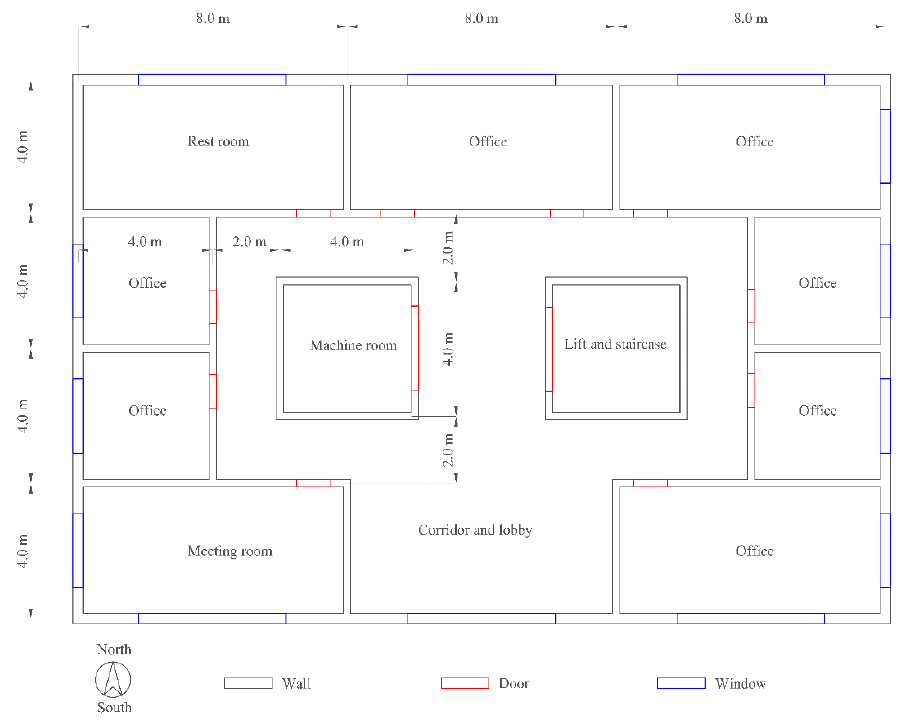
Figure 5. Layout and orientation of building. Table 2. Load simulation assumptions and schedules for the case